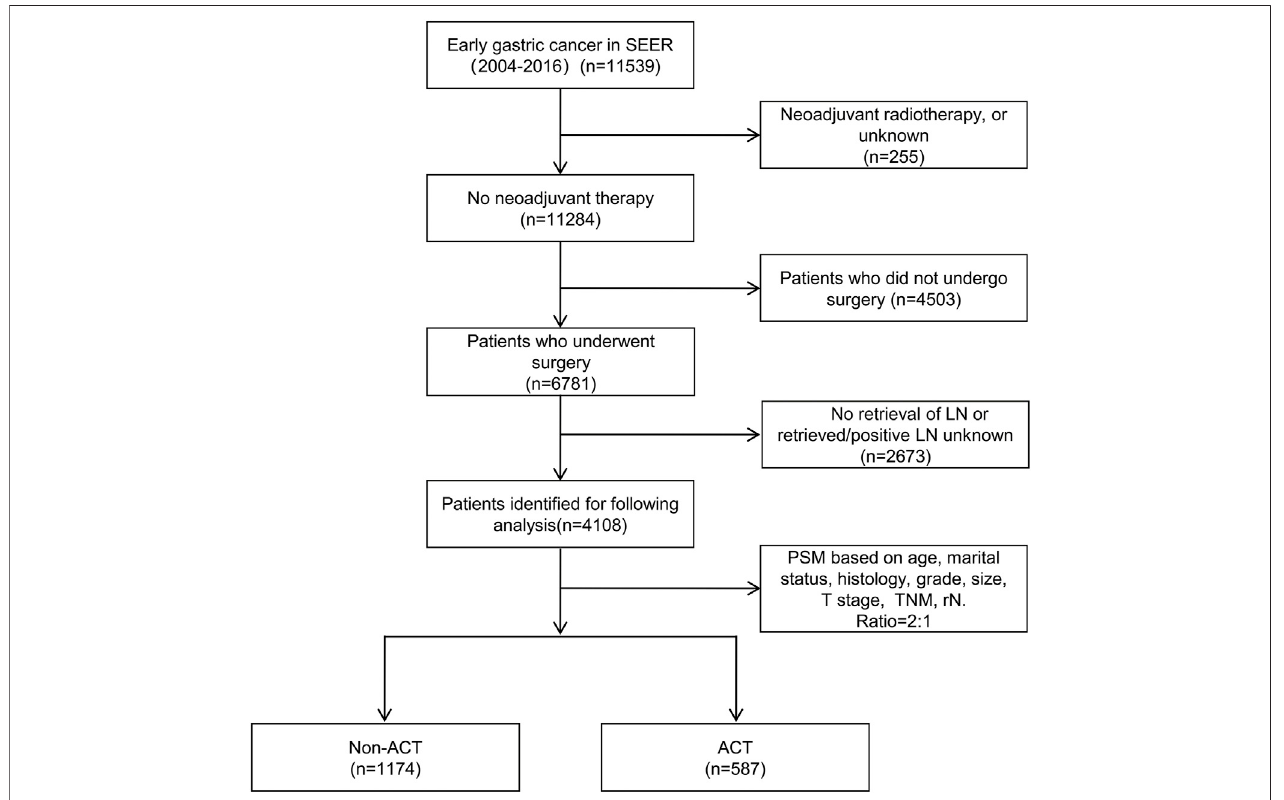
FIGURE 1 | Flowchart of the selection process of included